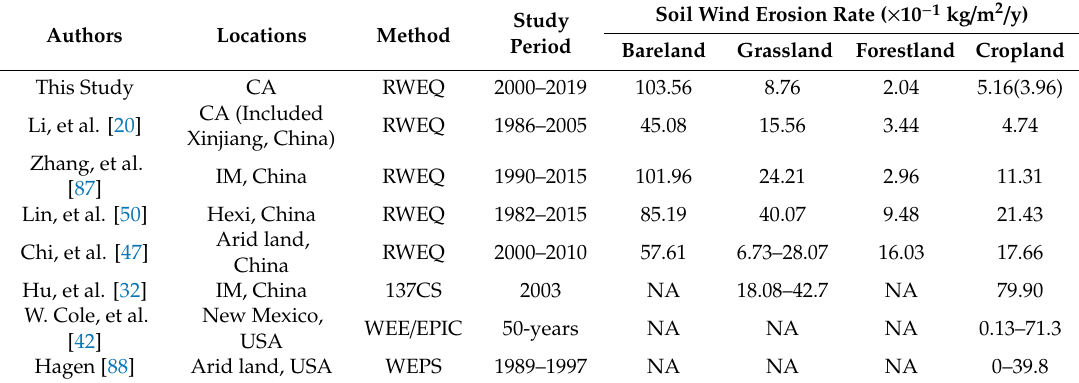
Table 2. Soil wind erosion rate studies in CA and other regions with similar